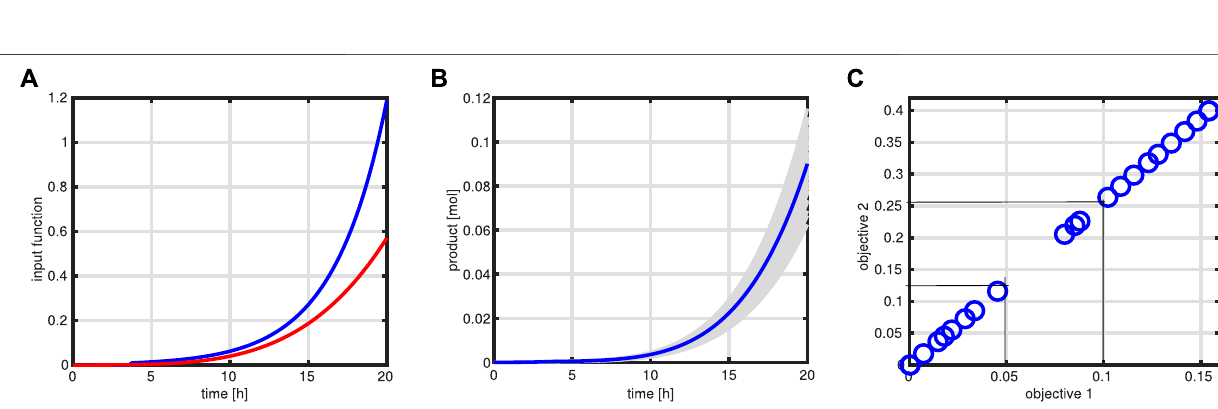
Frontiers in Molecular Biosciences |